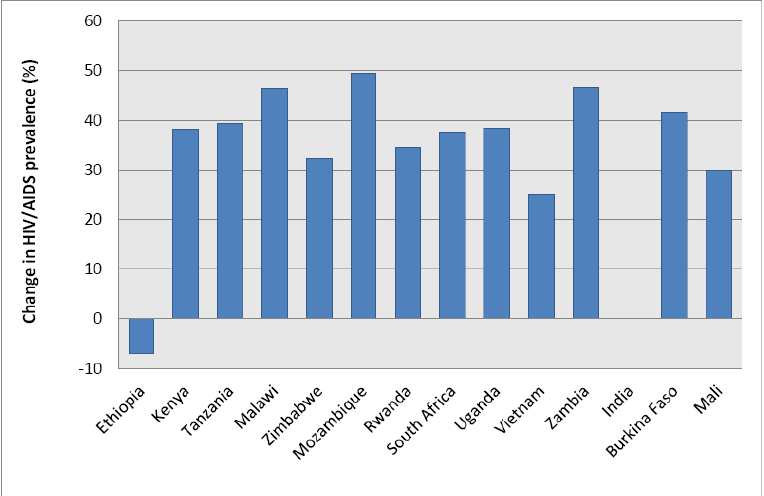
Figure 2. Percent Decrease in HIV/AIDS Prevalence from 2009-2011 in Developing